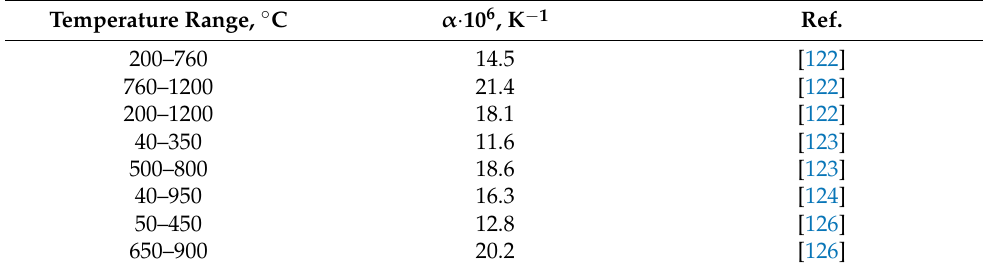
Table 7. Thermal expansion coefficients of Sr 2 Fe 1.5 Mo 0.5 O 6- δ in air. These data are also presented in Figure